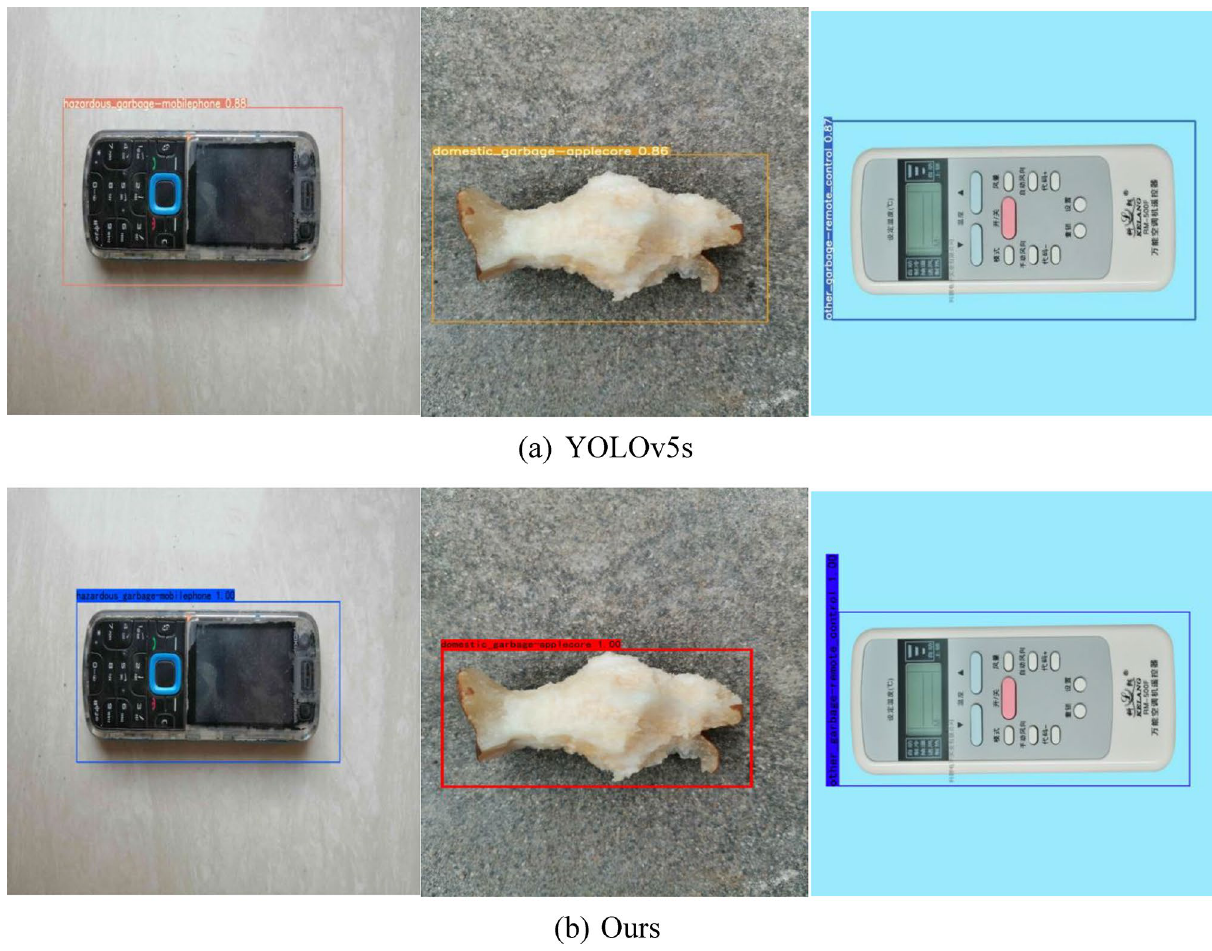
Figure 11. Prediction frame detection effect